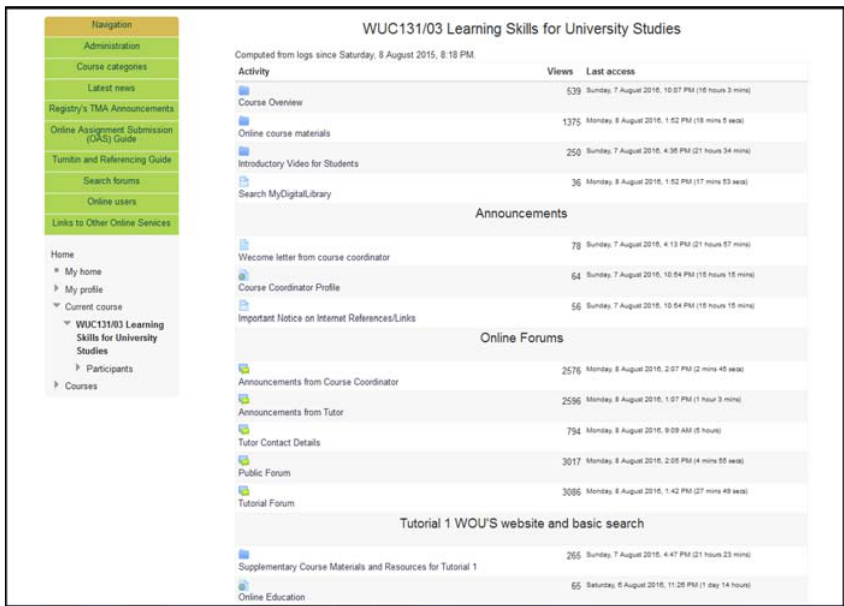
Figure 5. LMS ’ s activity